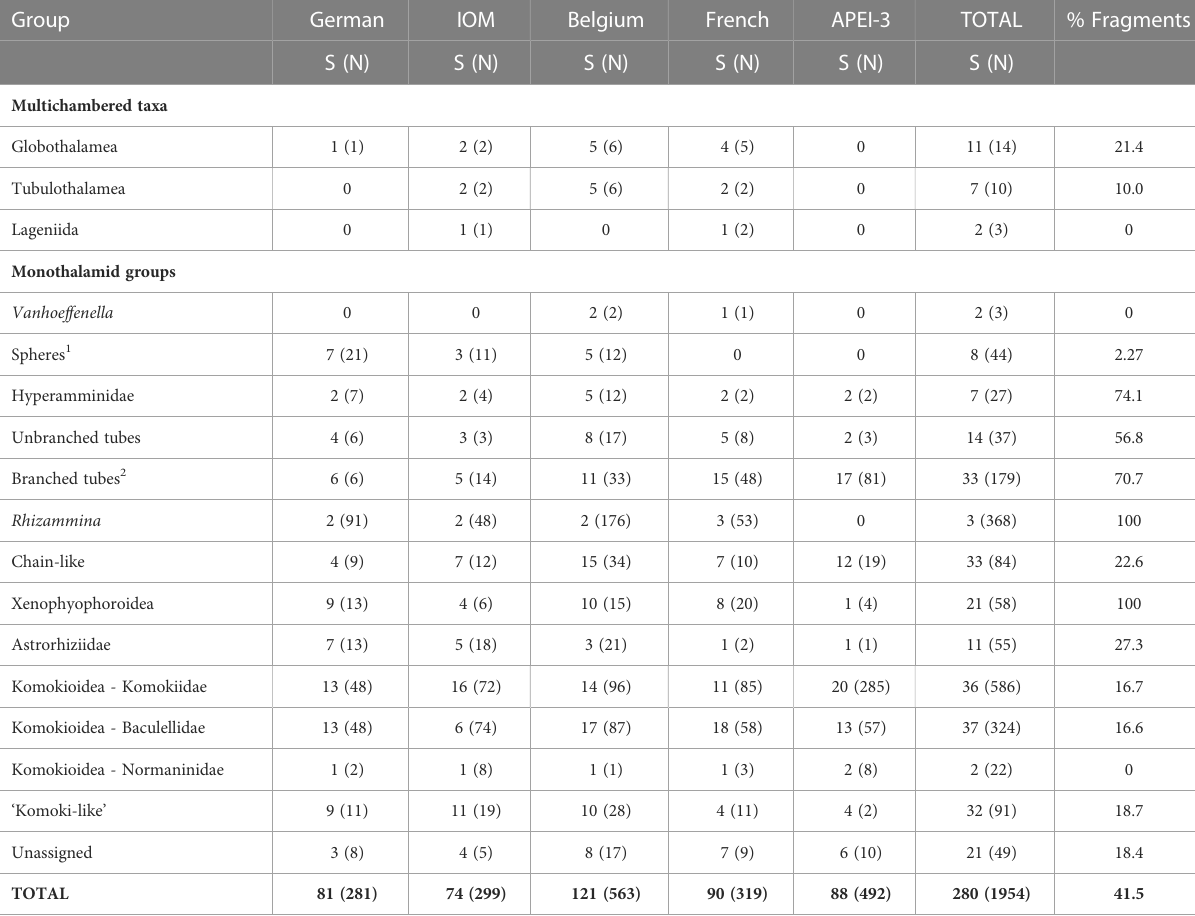
TABLE 3 Numbers of species assigned to major groupings in the four license areas and